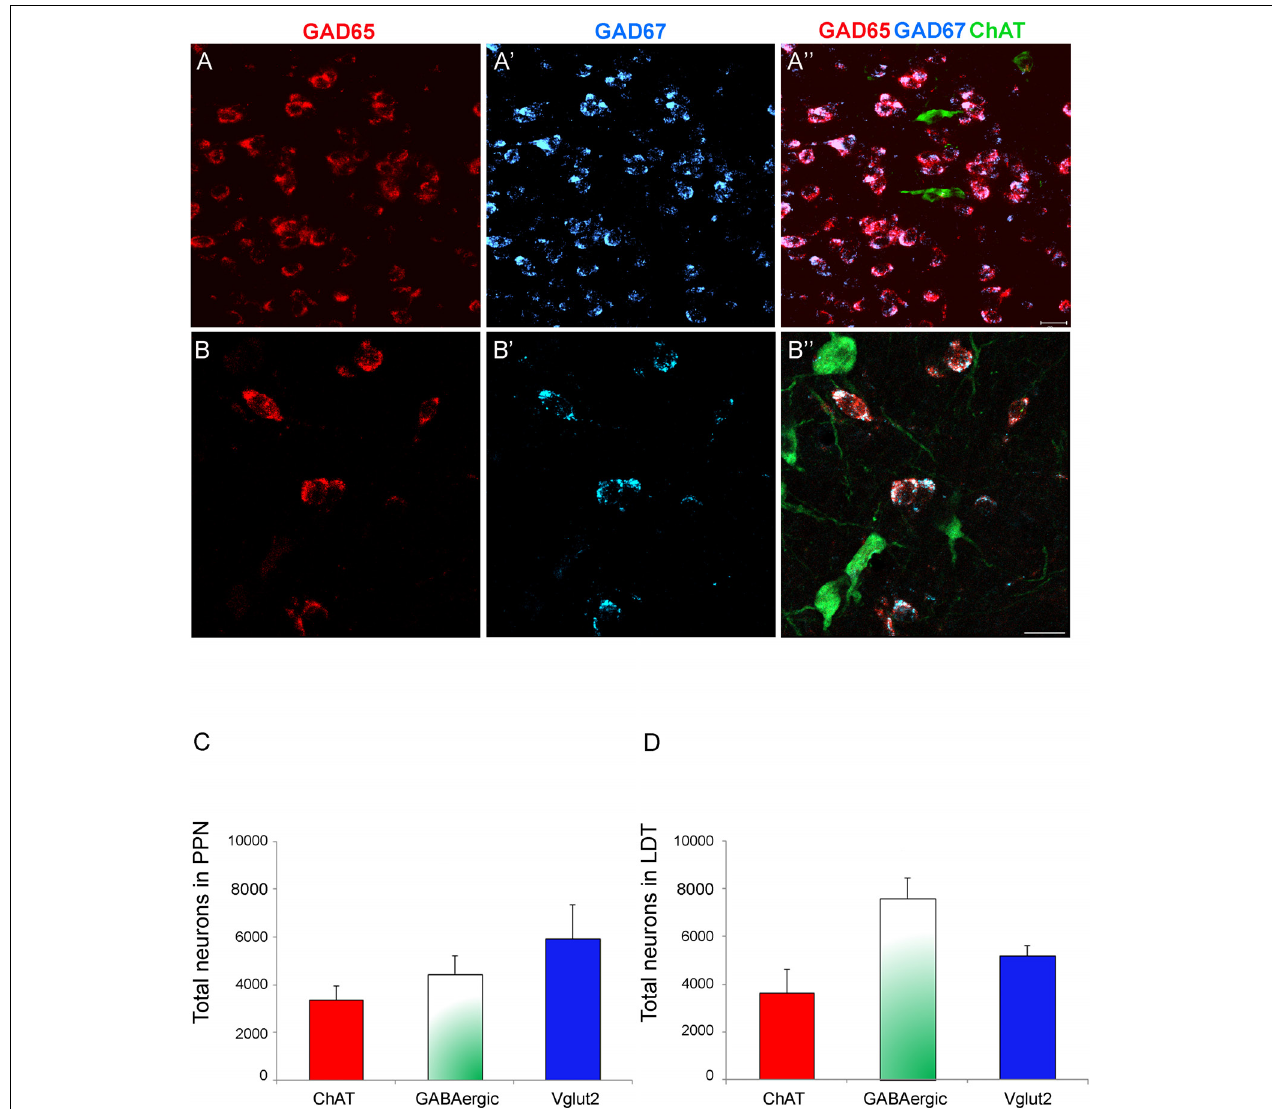
FIGURE 7 | High degree of colocalization of GAD65 and GAD67 in PPN and LDT neurons. (A–B”) Confocal images of triple labeling in the PPN showing GAD65 expression only ( A,B , red channel)„ GAD67 expression only ( A’,B’ , blue channel), and the merged image of the three channels ( A”,B” , cholinergic cells in green). The merged image shows the high degree coexpression of GAD67 and GAD65 mRNAs in GABAergic cells (pink neurons). Scale bar: 20 µ m. (C–D) Graphs showing the relative densities of the three cell phenotypes in the PPN (C) and LDT (D) . The estimation of the total GABAergic cell density was calculated from the data of single GAD65 and GAD67 neuronal densities and the degree of colocalization of the two GAD